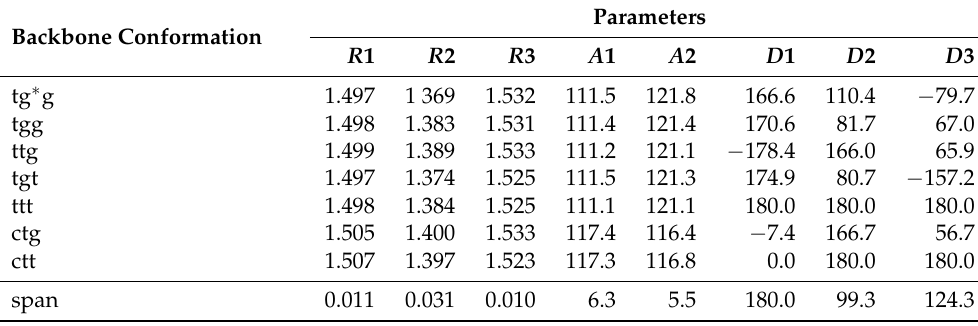
Table 3. The optimized conformation type and geometrical parameters of the stable ACh + conformers ( R (in Å); A and D (in deg.)).